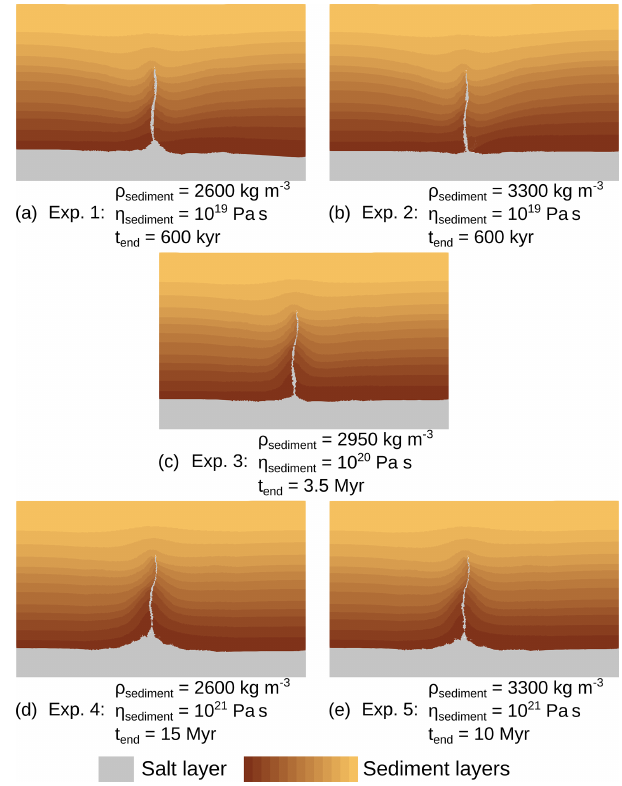
Figure 10. Results of the five restoration experiments done on the salt model setup of Fig. 8, after different time spans t end